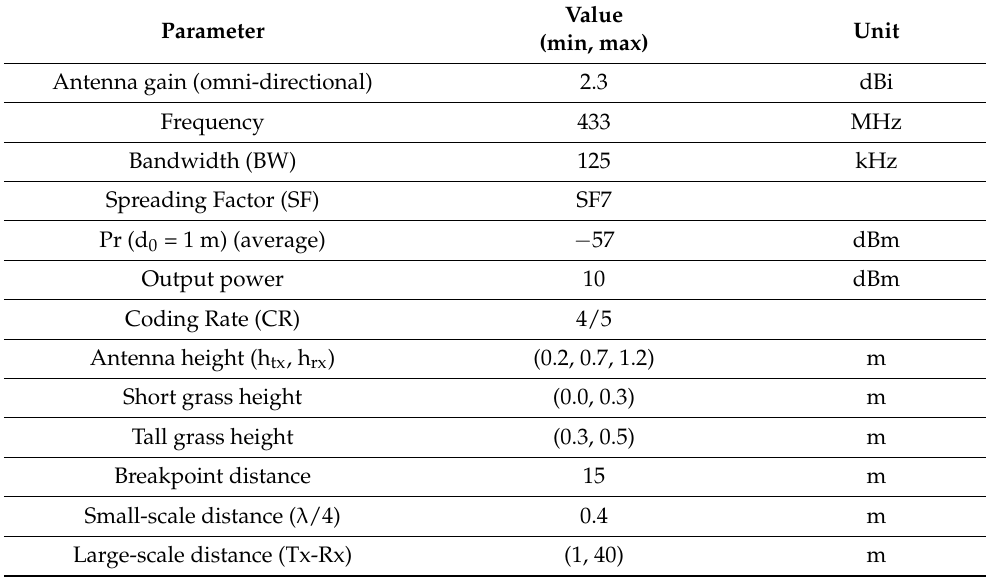
Table 1. Summary of the equipment and measurement